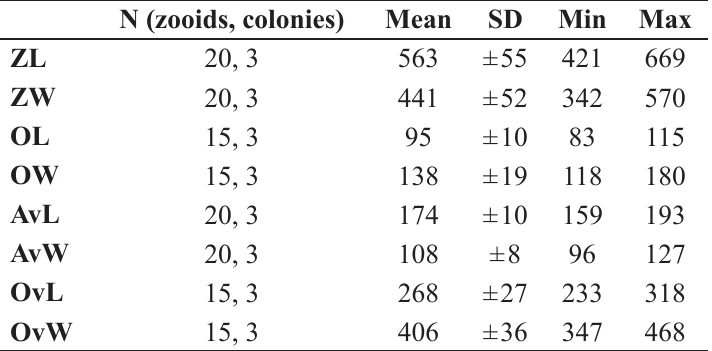
Table 7. Measurements in µm of Microporella lingulata sp. nov., Recent, Foveaux Strait, New Zealand; paratypes NIWA 144887, 144888,